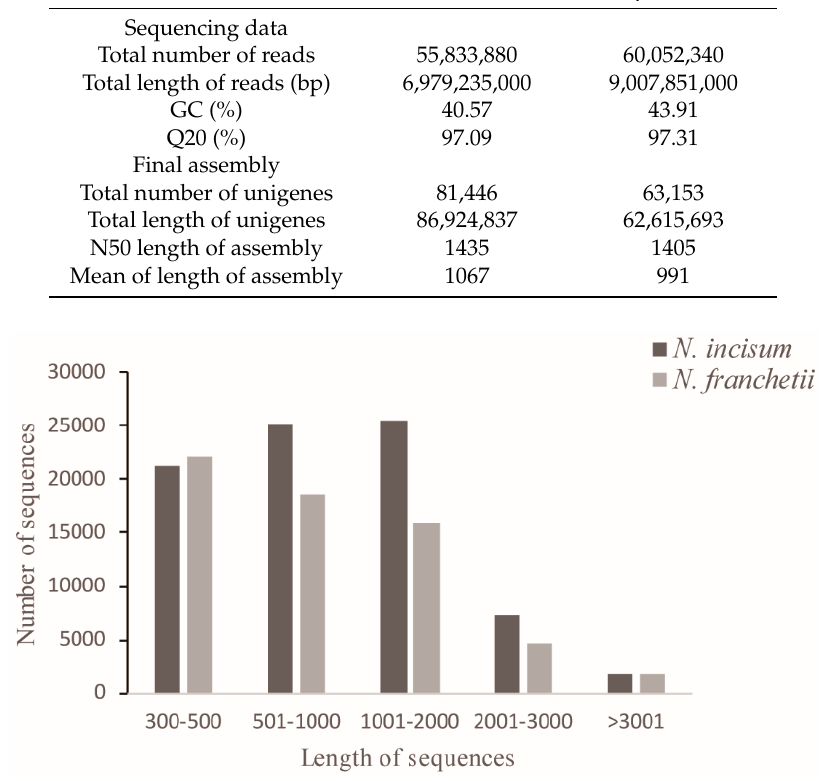
Figure 1. Overview of Notopterygium incisum and Notopterygium franchetii assemblies and annotations.